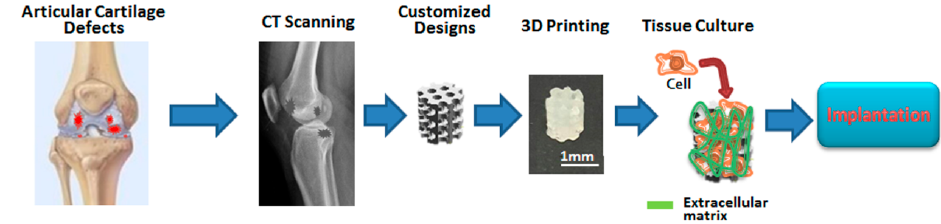
Figure 9. The proposed process of customizing cartilage tissue for cartilage repair in the future. The computerized tomographic (CT) images of the articular cartilage defects are applied to enable the design of the printed scaffolds and three-dimensional reconstruction. The customized porous scaffolds which are similar to the shape of the cartilage defect of the recipient site are designed and printed with water-based light-cured PU/HA hybrid materials by DLP technology. Furthermore, the targeted cells are cultured on the printed PU/HA hybrid scaffolds. After tissue maturation, the cartilage tissues can be used in implantation for cartilage repair.